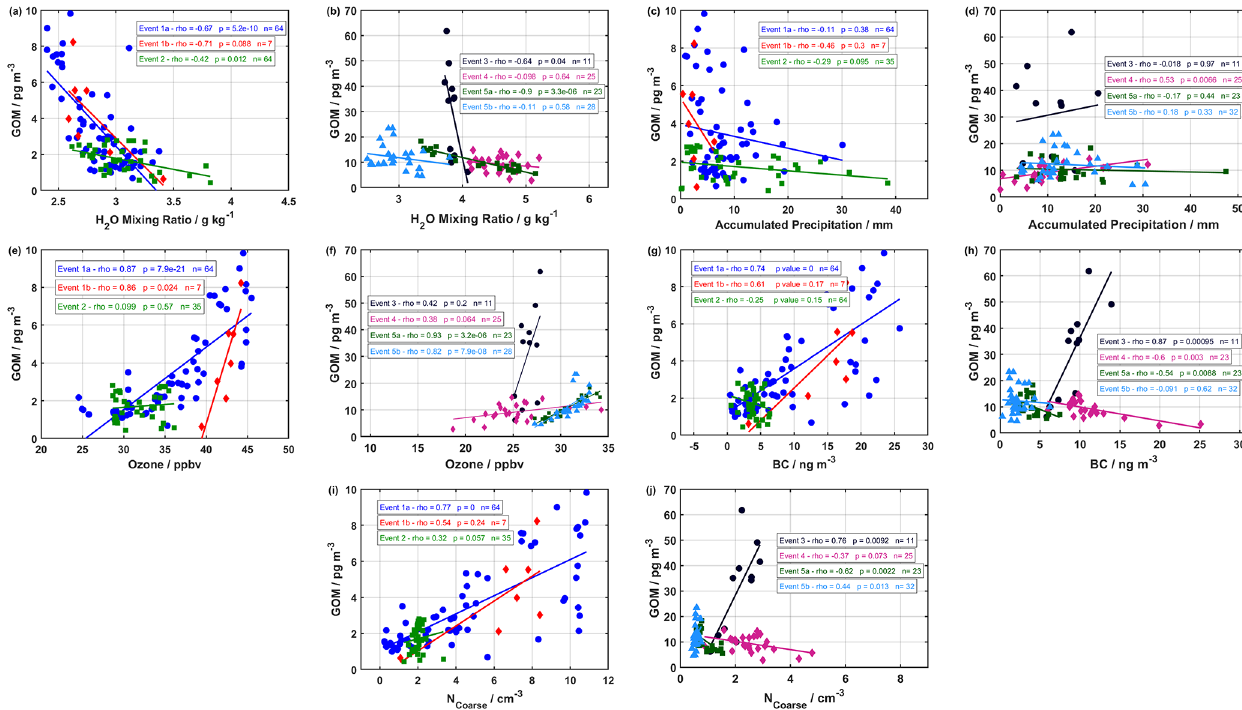
Figure 7. Correlation analysis of GOM with (a, b) H 2 O mixing ratio, (c, d) accumulated precipitation, (e, f) ozone, (g, h) BC, and (i, j) N Coarse for the 2019 and 2020 campaigns, respectively. The Spearman rank correlation coefficient (rho – ρ ), the p value, and the number of observations are listed for each event in each